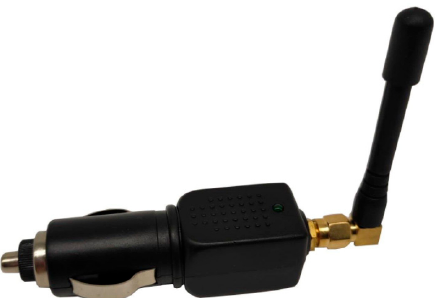
Figure 4. Typical illegal in-car chirp jammer (aka Personal Privacy Device or PPD) [7].